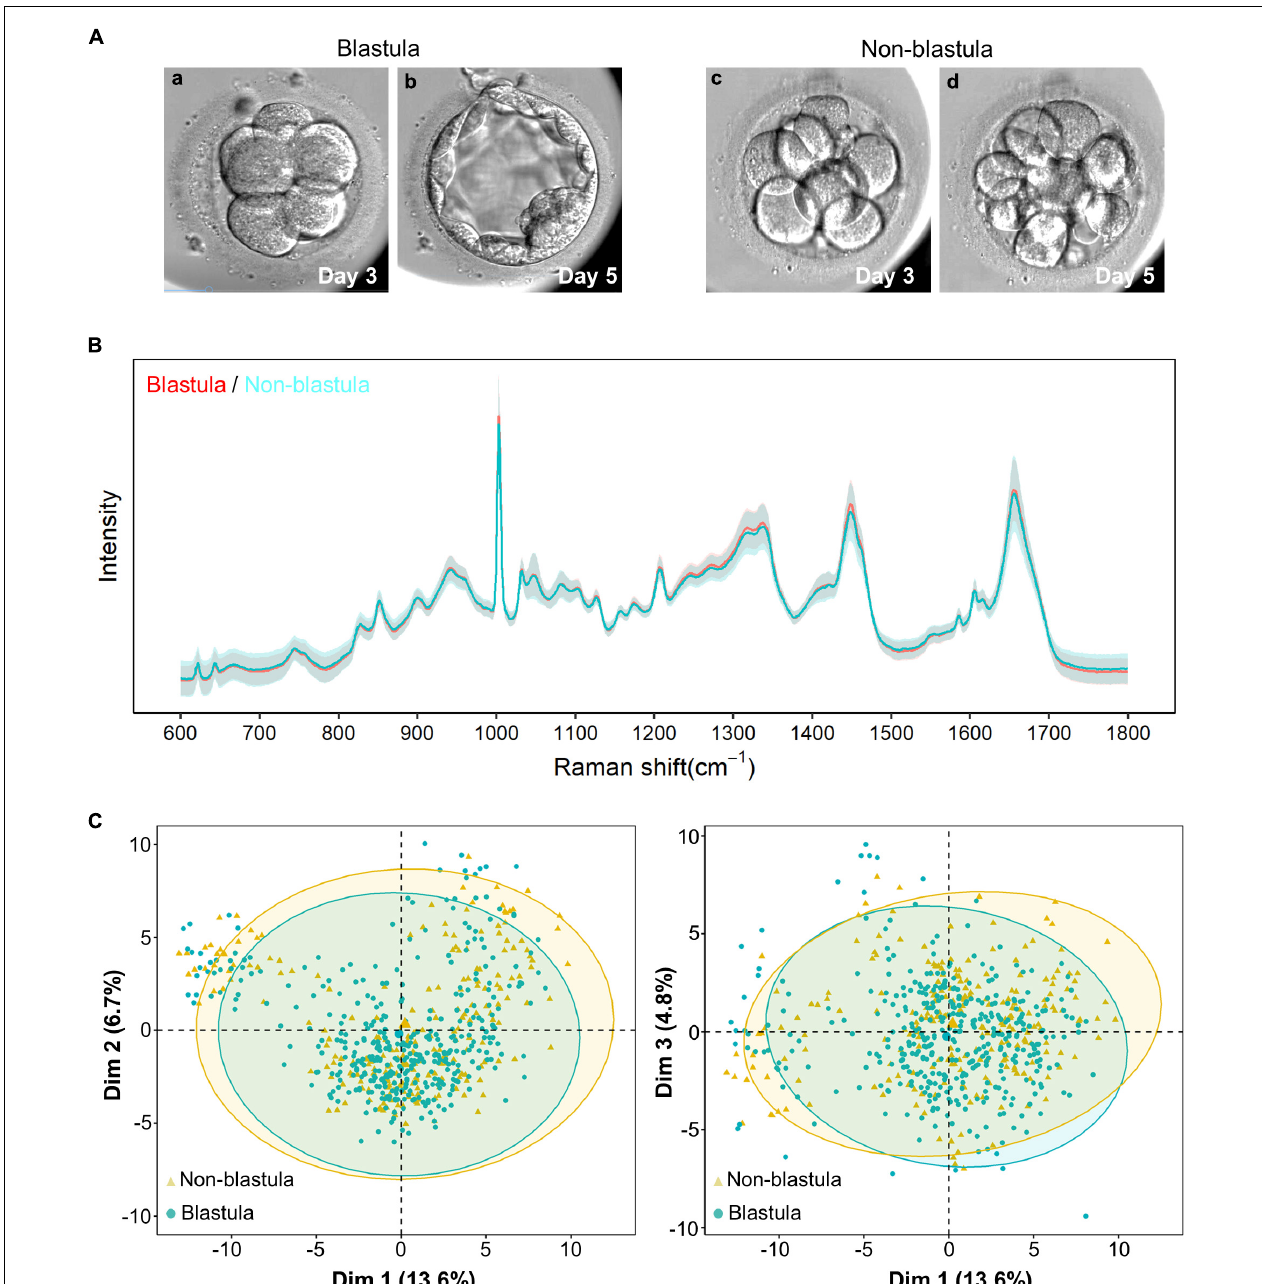
FIGURE 1 | Raman spectrum and unsupervised clustering with principal component analysis (PCA). (A) The pattern diagram of blastula and non-blastula group. The cleavage stage embryos are similar at day 3 (a,c) , the cleavage stage embryos developed to blastocysts (b) in blastula groups, yet arrested at cleavage stage (d) in non-blastula group. (B) The intensity from both the blastula and non-blastula group are plotted vs. the Raman shift. Solid line represents the average of the Raman spectrum data, and the shading depicts the standard deviation of the Raman spectrum. The average Raman spectrum intensity of the blastula group is depicted by a red line, and the standard deviation of this group is depicted by light red. The color used for the non-blastula group is blue for the average Raman spectrum intensity line, and light blue for the standard deviation. Most part of the two lines overlap with each other, where only blue line is visible. The parts that both lines are shown indicate places where the groups are different. The shading for both groups overlap with each other most of the time, indicating that both groups had similar variations. (C) Unsupervised clustering using PCA showed no specific pattern for the first three principal components. Dim1, Dim2, and Dim3 are the first, second and third principal components, respectively. The numbers in parentheses represent the contribution ratio of the corresponding principal components. The ellipses of the clusters are drawn according to the 95% confidence interval of the data. The blastula and non-blastula group are highly consistent with the first three dimension, as shown by the first three principal